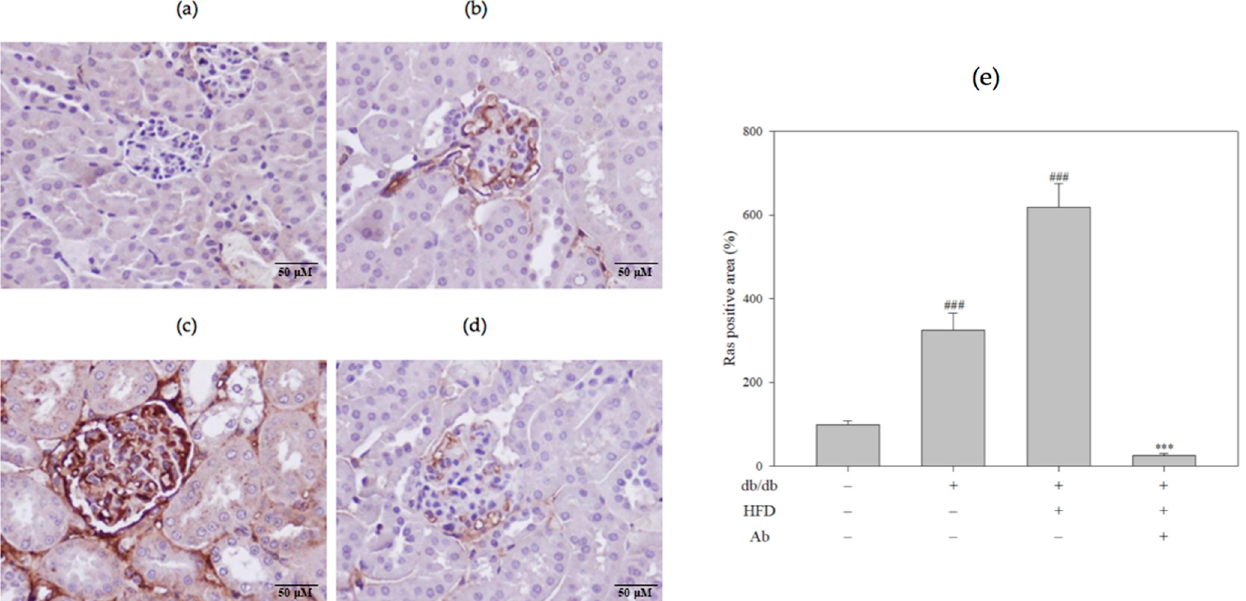
Figure 5. Ab decreased renal Ras expression. Renal Ras expression was detected with immunohisto- chemical analysis. Light photomicrographs of kidney sections from the ( a ) control group (C57BL/6 mice), ( b ) db/db group, ( c ) db/db+HFD group, ( d ) db/db+HFD+Ab group were displayed (400× mag- nification). The brown color on the renal biopsy represented Ras expression. ( e ) Quantification of the Ras-positive area. Data are presented as mean ± SD; n = 3 mice per group. The results were analyzed with Student’s t -test. ###, p < 0.001 compared with the control group. ***, p < 0.001 com- pared with the db/db+HFD